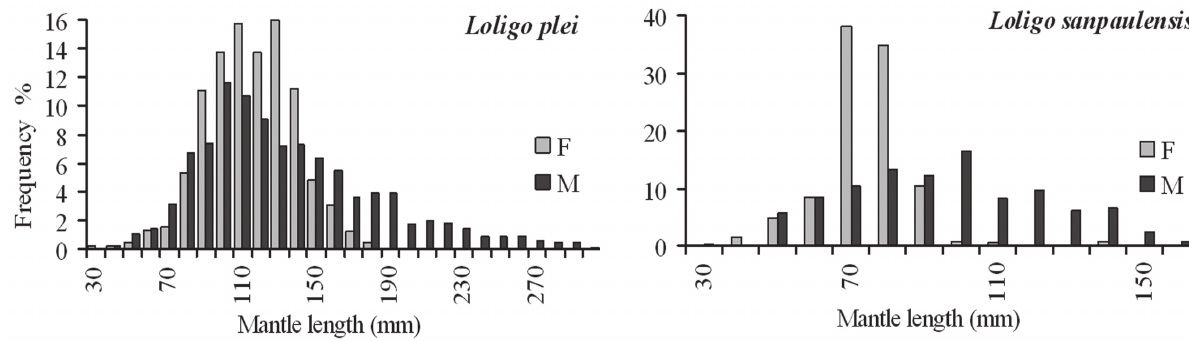
Fig. 1 . – Mantle length frequency distribution of L plei (1584 individuals) and L. sanpaulensis (938 individuals) caught by trawl fishing landings between 1999-2000 and 2002-2003. Black bars represent males and grey bars represent